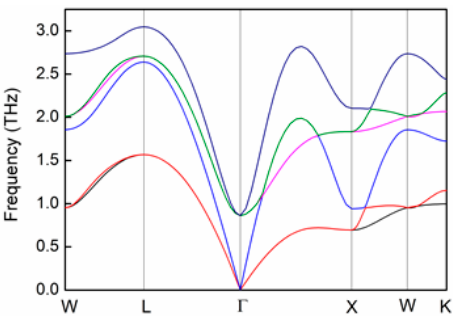
Figure 1. The phonon-dispersion curves of PbTe calculated from first principles for the W, L, Γ , X, and K-points of the reciprocal lattice.